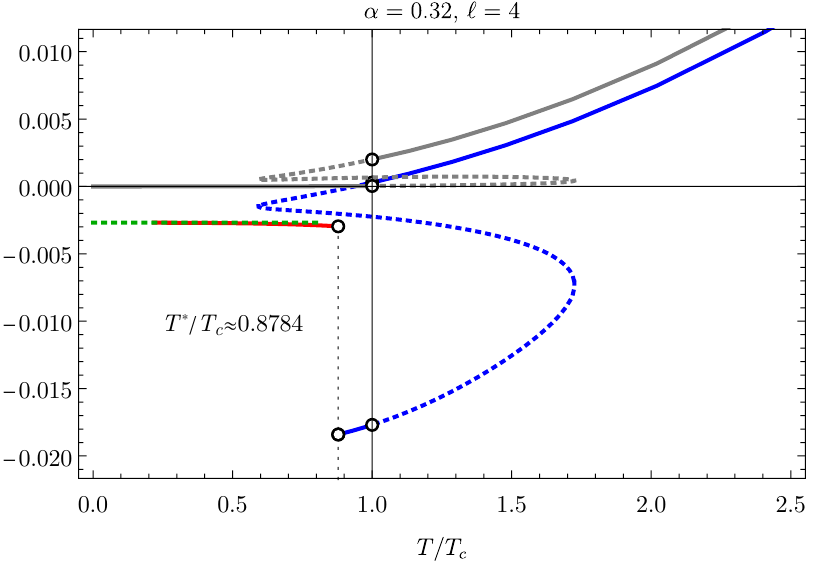
Figure 16 . QNEC 2 as function of T for black brane solution with α = 0 . 32 and ‘ = 4 . Blue and red lines show the QNEC 2 expression 1 (dashed) parts of the curves correspond to thermodynamically stable (unstable) phases. Red and blue segments correspond to different branches of RT surfaces that dominate at small and large separations, respectively. In addition, the dashed green curve shows the value of QNEC 2 of the corresponding T = 0 domain wall